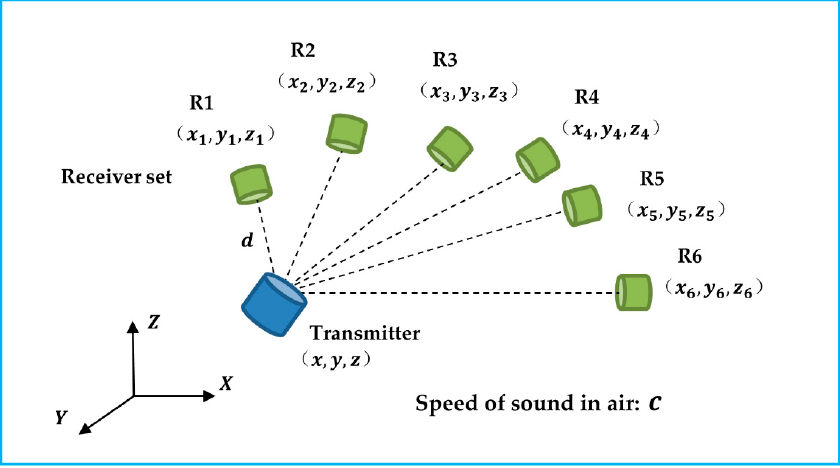
Figure 5. The transmitter sends out carrier signals to the receiver set. The unknow transmitter’s position and the speed of sound can be solved based of the time difference of arrival.